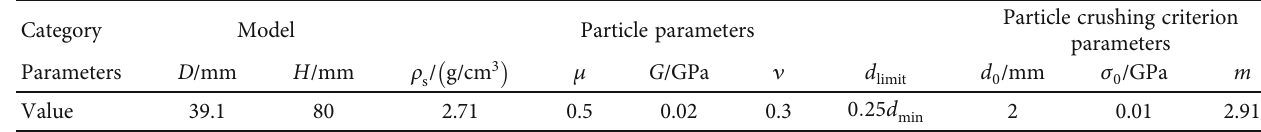
Table 2: Microscopic parameters of numerical simulation.